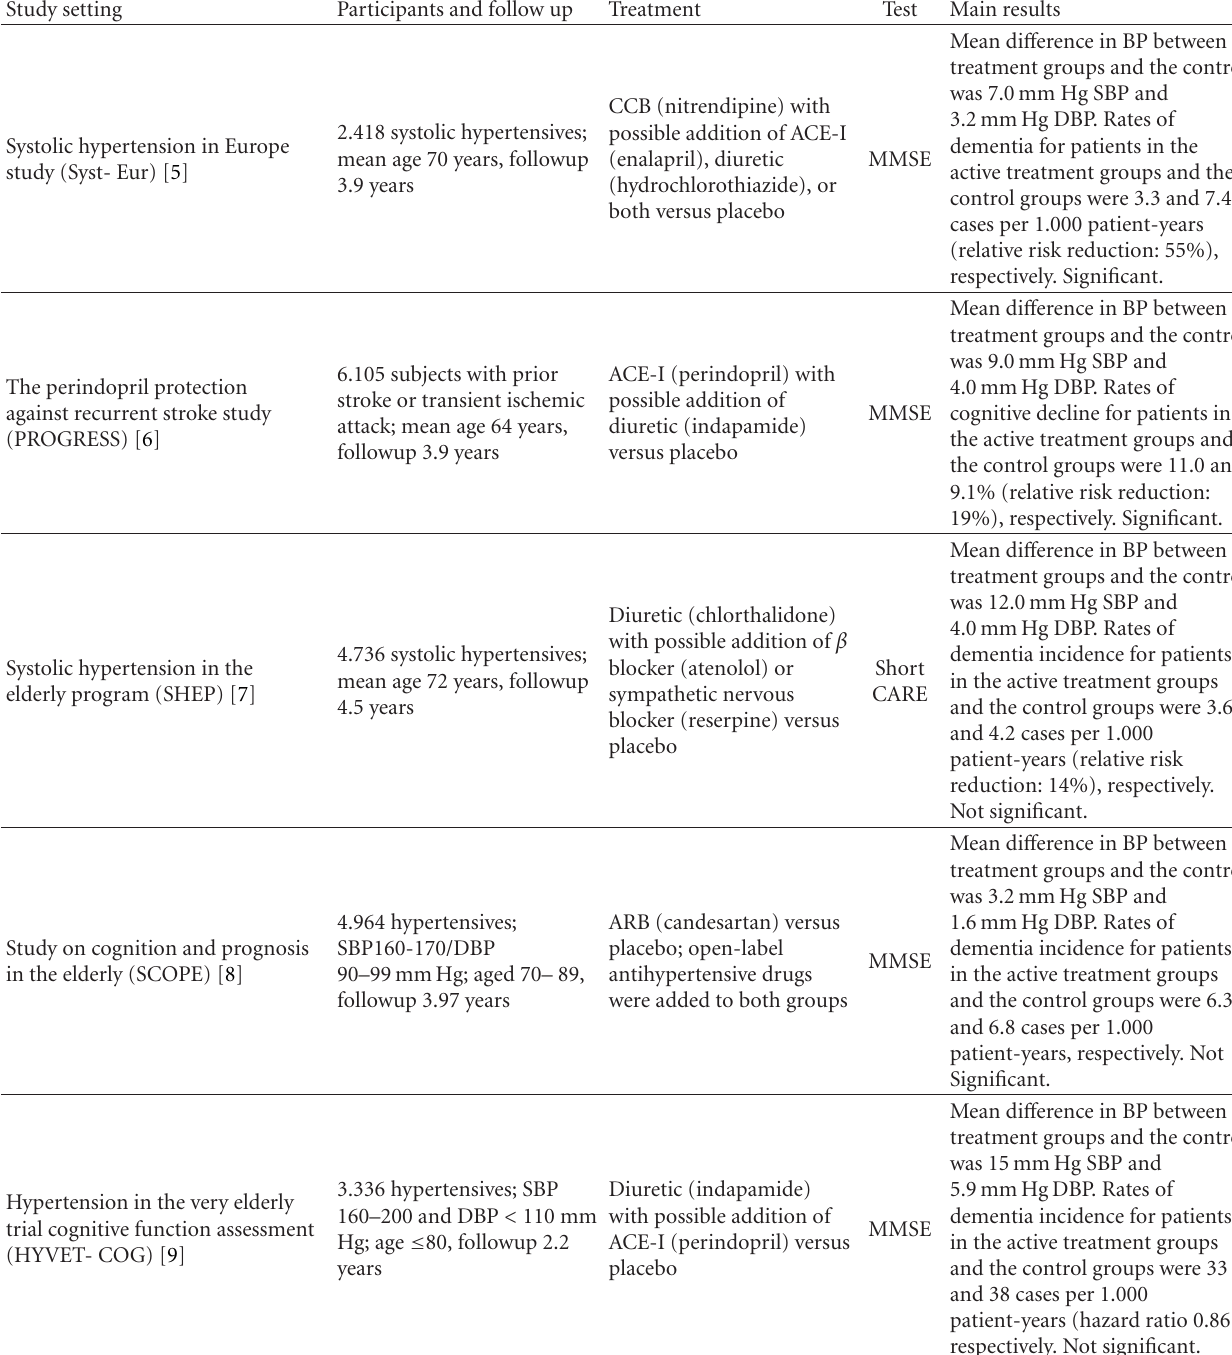
Table 1: Randomized controlled trials about antihypertensive treatments and dementia/cognitive